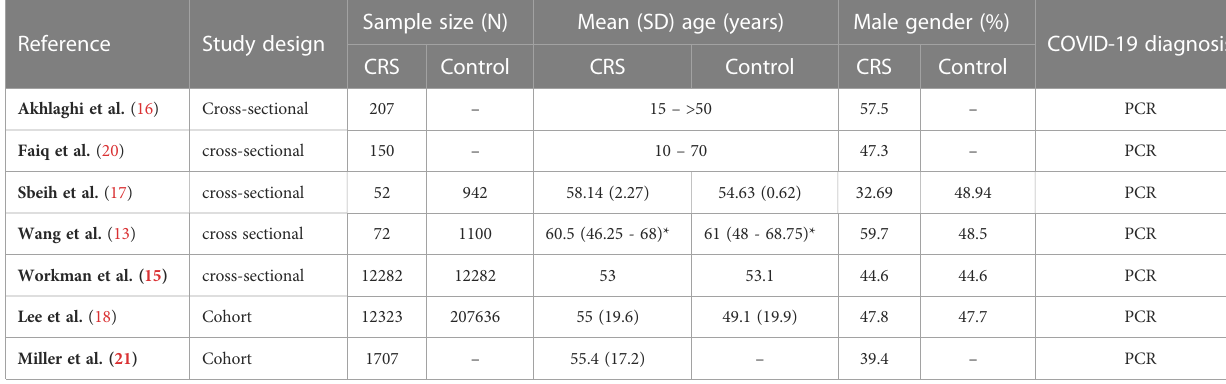
Baseline characteristics of included